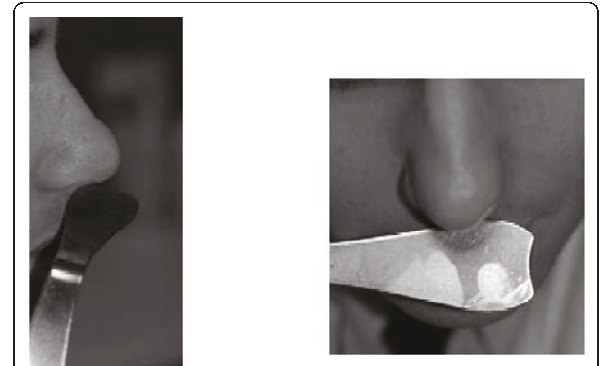
Figure 6 Anterior rhinoscopy allowing the evaluation of mucosal and/or anatomic pathology at the anterior part of the nasal cavity .